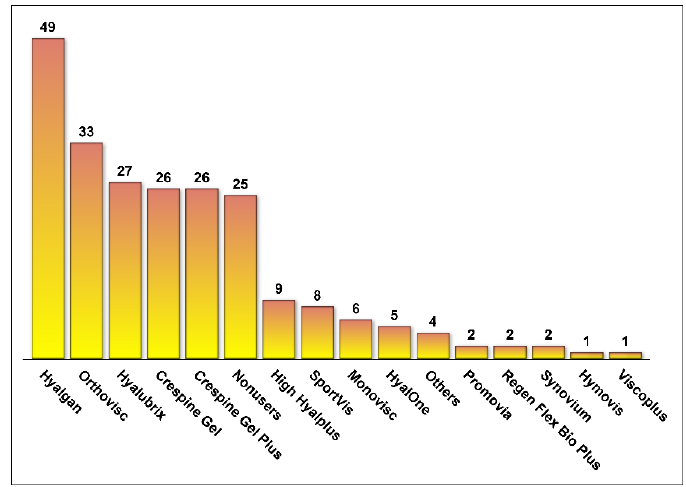
Figure 1. The frequency of utilizing hyaluronic acid products for osteoarthritis.